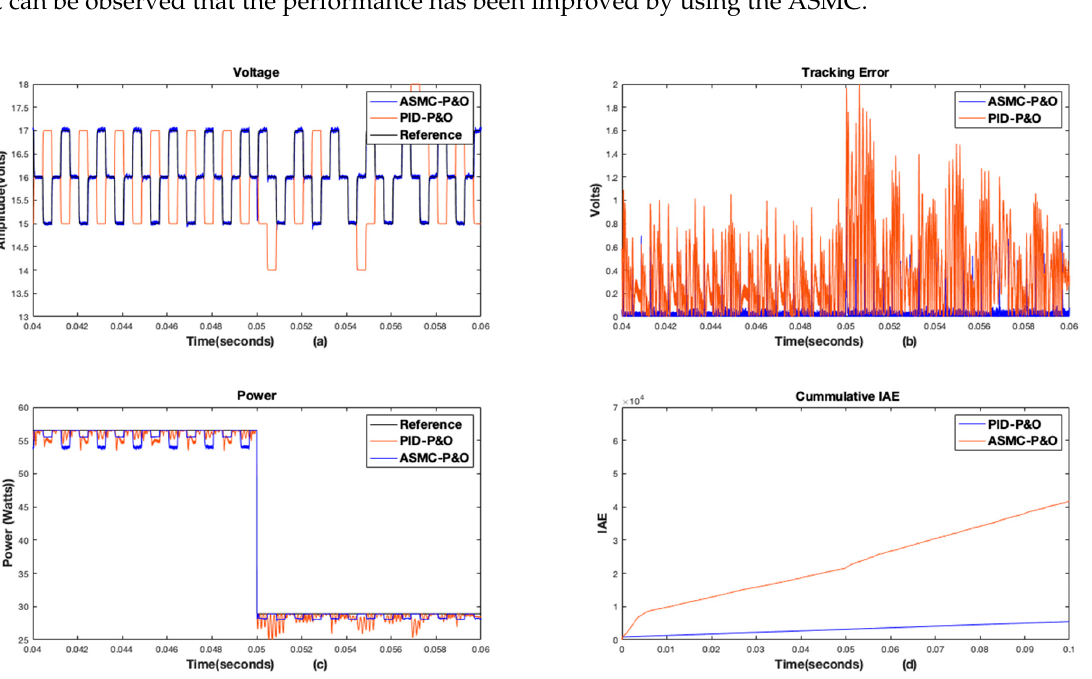
Table 3. Performance characteristics of the conventional controller and the proposed ASMC controller based on P&O MPPT.